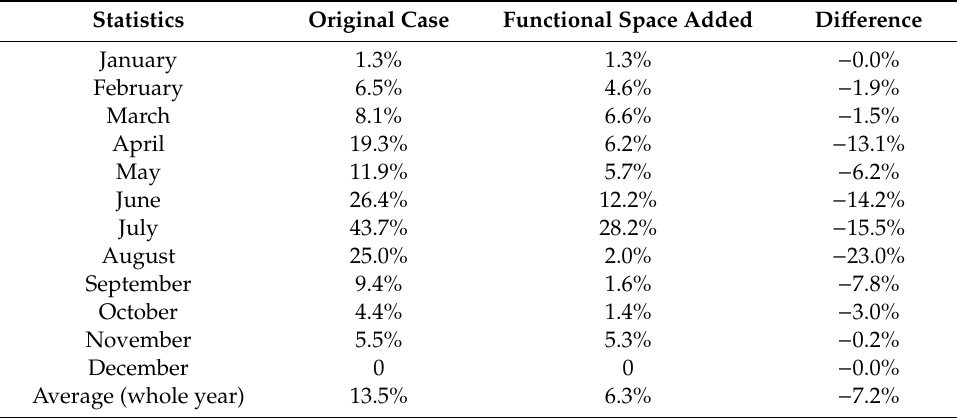
Table 7. Monthly rate of